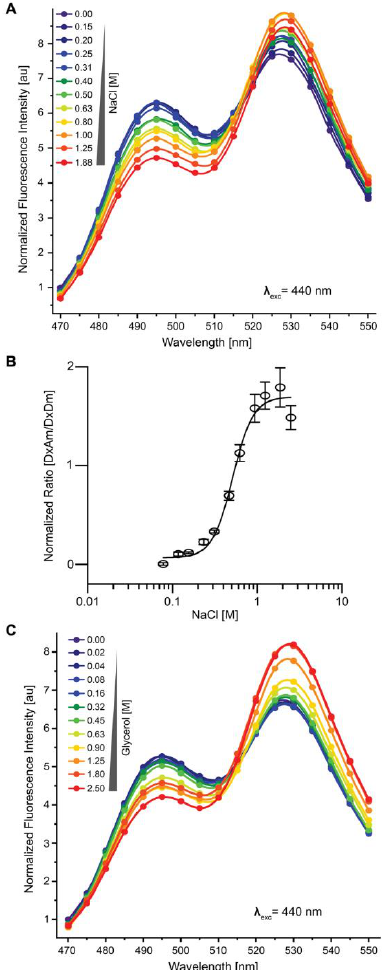
Figure 4. Osmolality-dependent ratio changes of OzTrac-MSL10-34 in yeast. ( A ) Response of the sensor to different NaCl concentrations. ( B ) Dose-response curve of OzTrac-MSL10-34 fitted to a non-linear regression with a Hill slope with a half-maximal effective concentration EC 50 of 573 ± 85 mM. ( C ) Response to the sensor to different glycerol concentrations. Axes as in Figure 2.